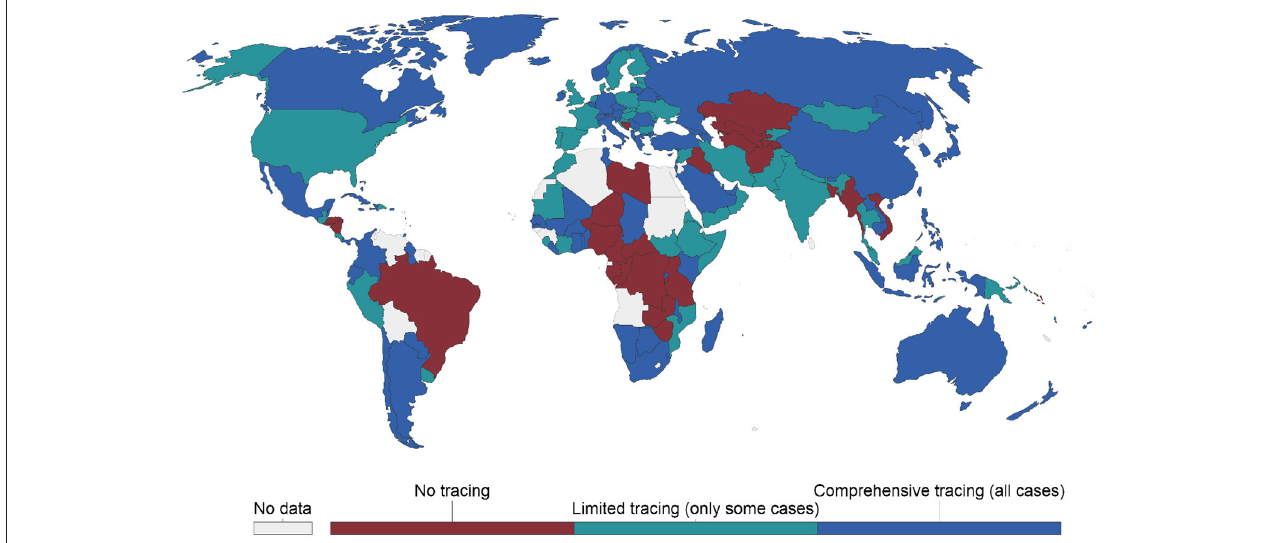
FIGURE 1 | Countries with COVID-19 contact-tracing initiatives as of July 6, 2021. Source: Hale et al. (33).